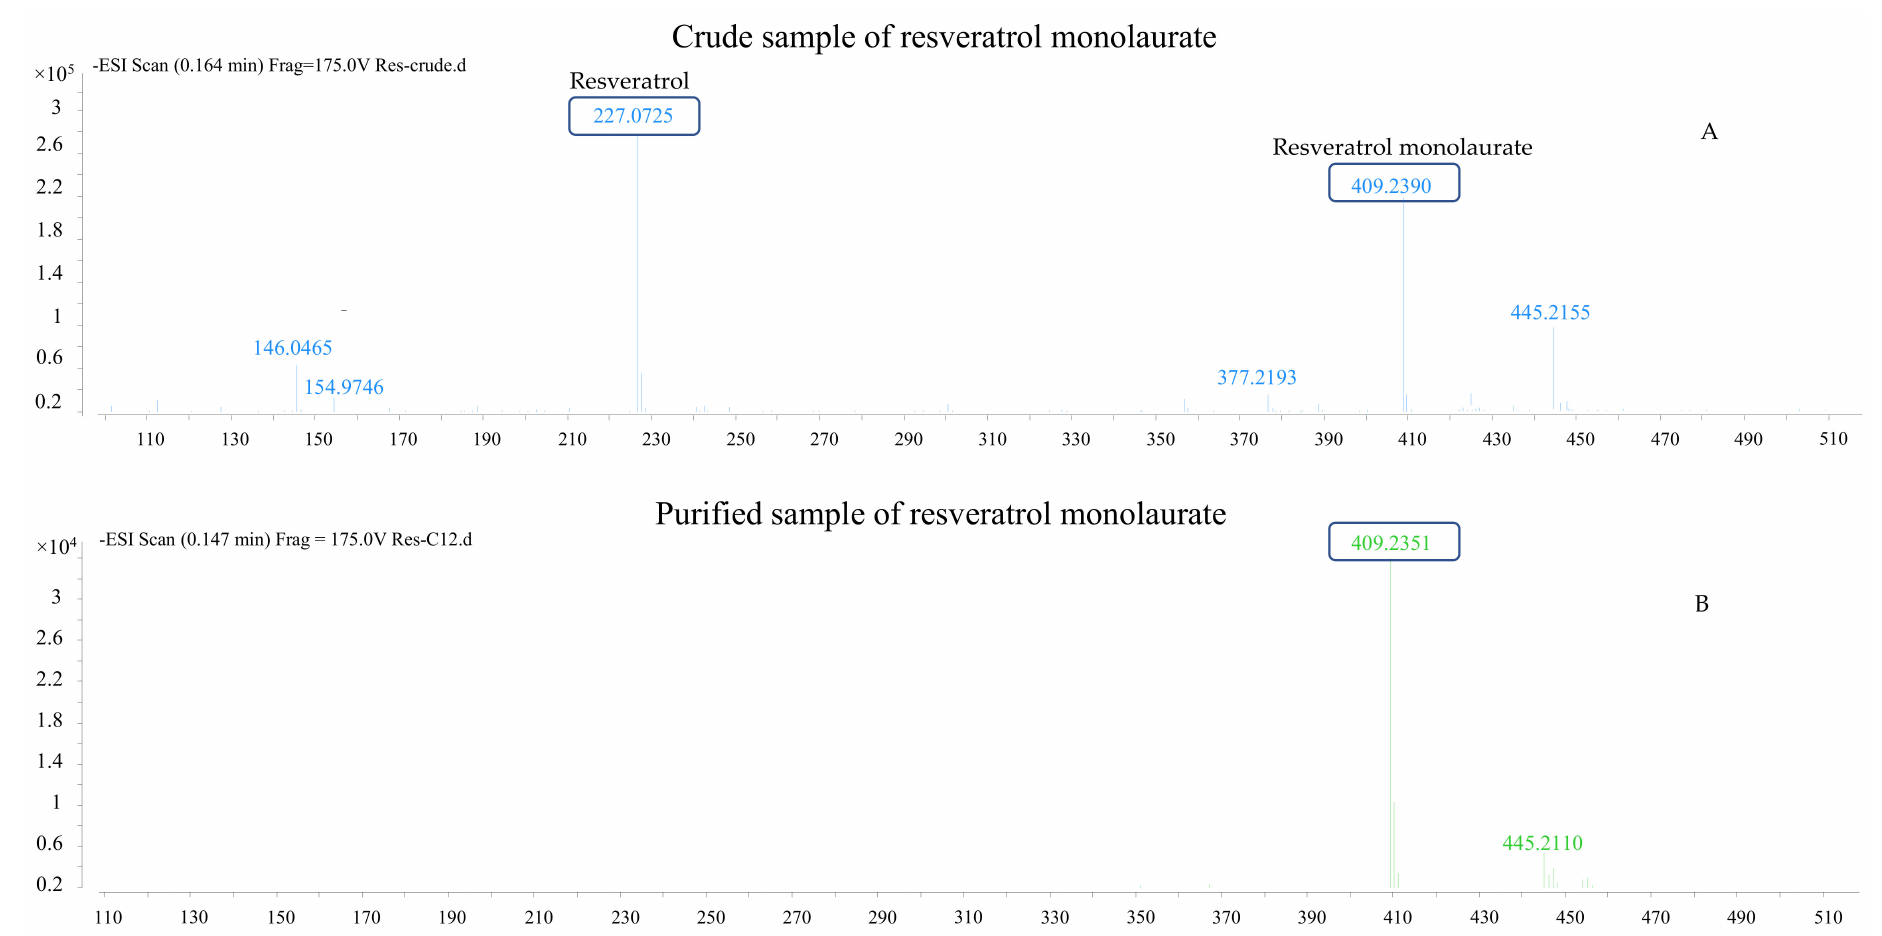
Figure 1. Mass spectra (negative mode) of resveratrol monolaurate (before and after purification) ( A ): Crude sample of resveratrol monolaurate; ( B ) Purified sample of resveratrol